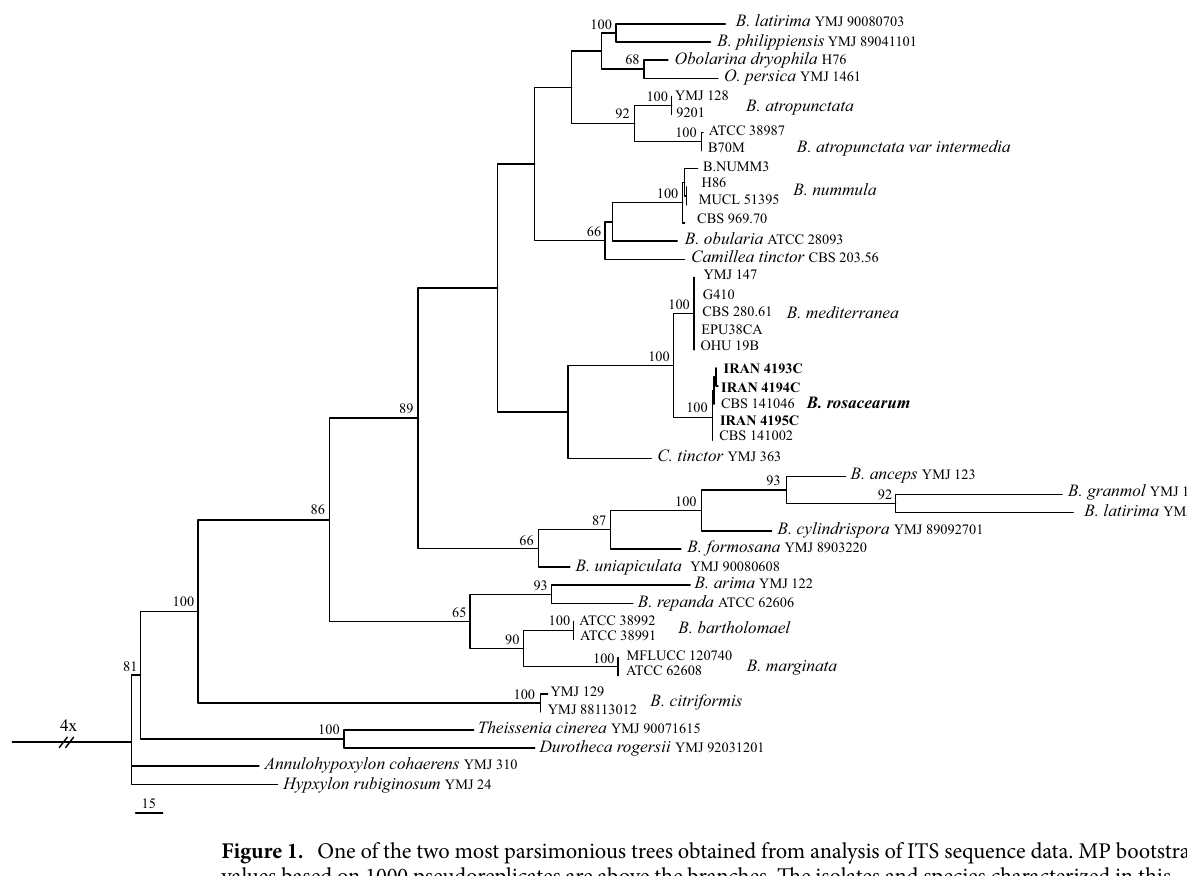
Figure 1. One of the two most parsimonious trees obtained from analysis of ITS sequence data. MP bootstrap values based on 1000 pseudoreplicates are above the branches. The isolates and species characterized in this study are in boldface. Bar = 15 changes. Annulohypoxylon cohaerens YMJ 310 and Hypoxylon rubiginosum YMJ 24 were included as outgroups.